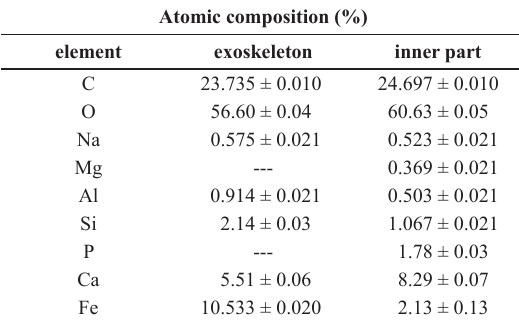
Figure 7. Pseudomorphs of framboidal pyrite covered by mineralized EPS. Table 2. Estimated chemical composition of the exoskeleton and inner part of the insect of Crato Formation. Data were obtained with EDX in semi-quantitative mode. The errors were automatic calculated by the analysis